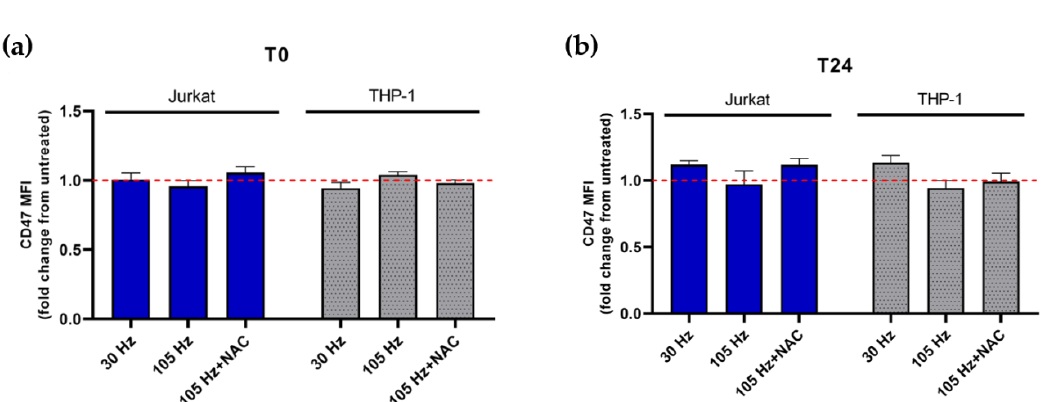
Figure 5. CD47 expression on Jurkat or THP-1 cells is not altered immediately or 24 h post NTP exposure. CD47 expression on Jurkat and THP-1 cells is comparably displayed at both ( a ) 0 h (T0) and ( b ) 24 h (T24) after NTP exposure relative to cells in the absence of NTP. Dotted line indicates no change with respect to cells not exposed to NTP. Data are presented as mean ± SEM. Significance was calculated using a Kruskal–Wallis test with Dunnett’s post-hoc test.